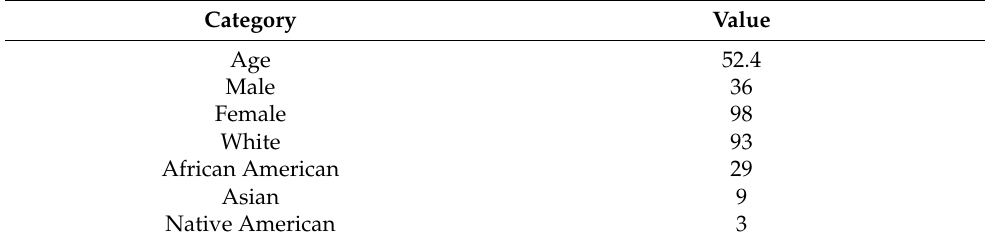
Figure 1. Gene expression in SSc-ILD vs. control patients. Table 1. Patients characteristics at baseline.